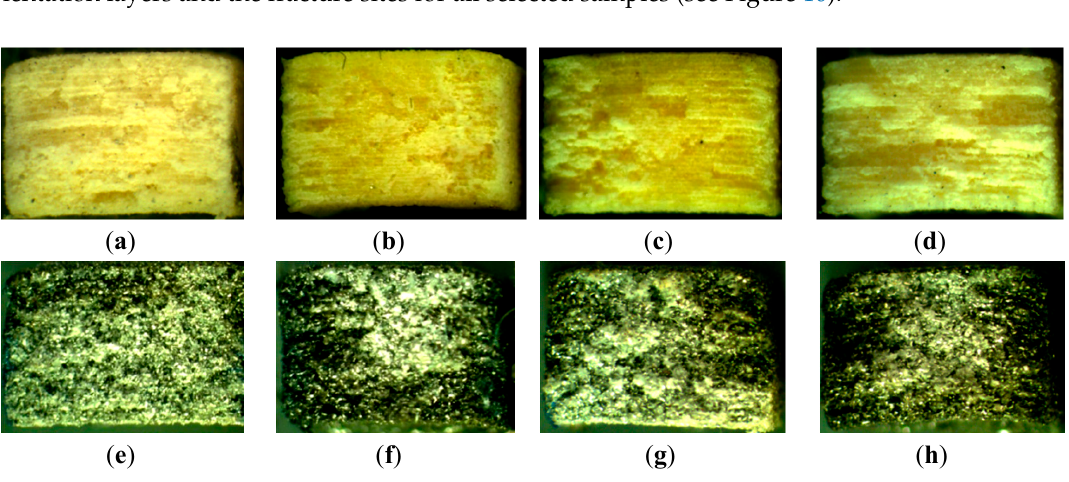
Figure 10. Fracture section of representative samples: PA2200-0° ( a ); PA2200-30°( b ); PA2200-45°( c ); PA2200-90°( d ); Alumide-0°( e ); Alumide-30°( f ); Alumide-45°( g ); Alumide-90°( h ).